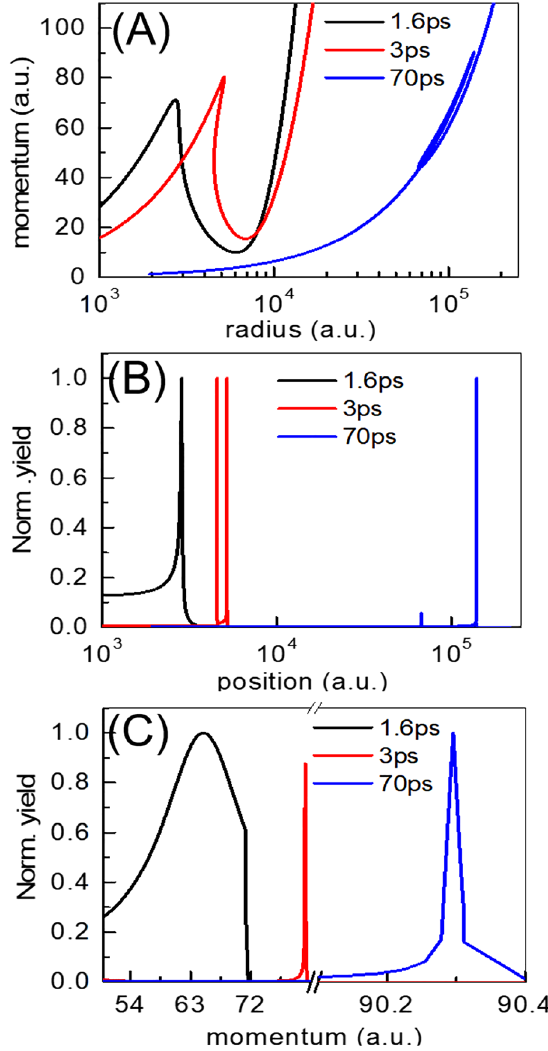
Figure5: Calculated results at three distinct moments (1.6, 3, and 70 ps) showing the mechanism of the shock formation in the H + ion emission. (A) The momentum of the fl ying ions at the different radius. Here the center of the nanosphere is de fi ned as the origin of the x -axis. (B) The normalized ion yields as a function of radius. (C) The normalized ion yields as a function of momentum. A stable sharp peak is formed at a fi nal momentum of around 90 a.u. at about 70